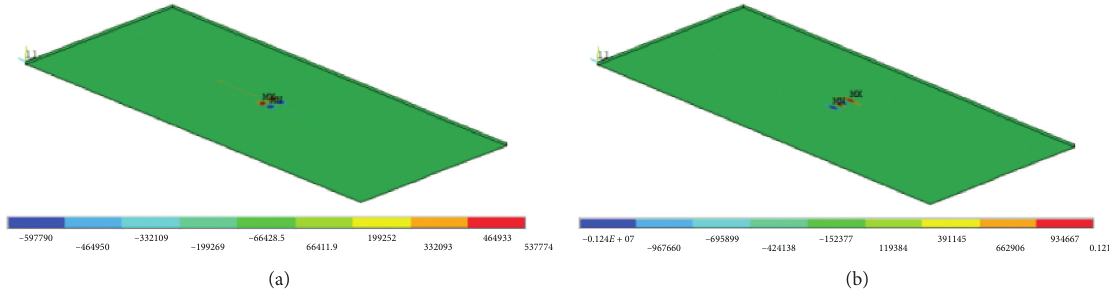
Figure 15: The shear stress diagram of the midspan pavement layer under dual-wheel load. (a) Interlaminar longitudinal shear stress. (b) Interlaminar transverse shear stress.